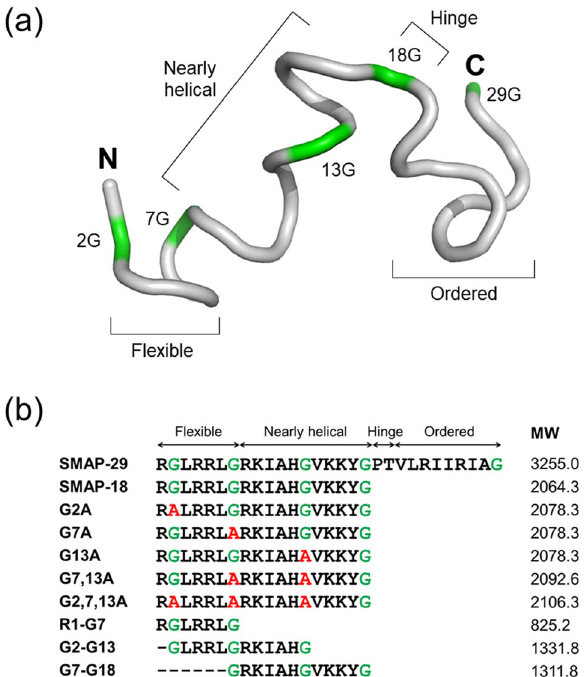
Figure 1. Three-dimensional structure of SMAP-29 and amino acid sequences of SMAP-18 analogs. ( a ) NMR solution structure of SMAP-29 solved in 40% trifluoroethanol (PDB ID 1FRY). The N-terminal flexible, nearly helical, hinge, and C-terminal ordered regions are indicated. The glycine residues are colored in green. ( b ) The amino acid sequences and molecular weights of SMAP-18 analogs synthesized in this